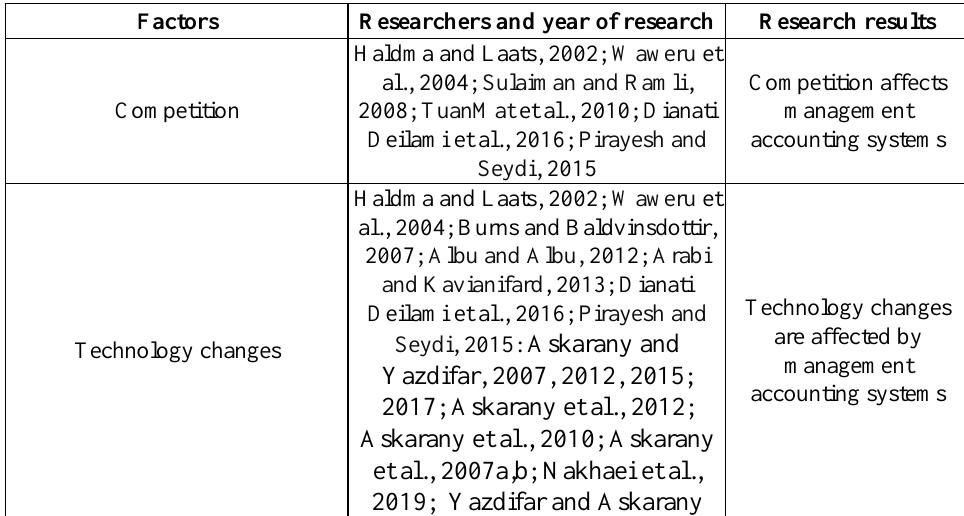
Table 1. The results of researchers' researches in the study of external and internal organizational